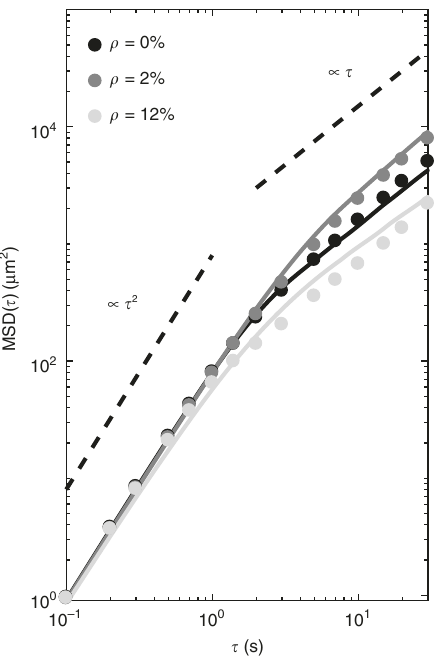
Fig. 8 E. coli cells ’ mean square displacement for different obstacle densities. Average mean square displacements (MSDs) of E. coli cells swimming on a smooth surface ( ρ = 0%), in the presence of a few obstacles ( ρ = 2%) and at higher obstacle densities ( ρ = 12%) in experiments (circles) and simulations (solid lines). The MSD at ρ = 2% shows a clear enhancement in diffusivity for the cells when compared to the MSD at ρ = 0%. The MSDs calculated from simulated trajectories match well the experimental ones. Both in experiments and simulations, the MSD at ρ = 12% shows a decrease in diffusivity when compared to the MSD at ρ = 0%. This decrease is lower in simulations rather than in experiments as our model does not account for the fact that, in experiments, cells can stop at an obstacle for a prolonged period of time, thus inducing a stronger transient subdiffusive behaviour. The two dashed lines, respectively, show ballistic ( ∝ τ 2 ) and diffusive ( ∝ τ ) behaviour for reference. Each experimental MSD curve was obtained as an ensemble average over at least 30 trajectories (each at least 30 s long), while each simulated MSD curve was calculated as an ensemble average over 20,000 trajectories (each 30 s long) obtained from 200 different obstacle con fi gurations with 100 non-interacting particles each